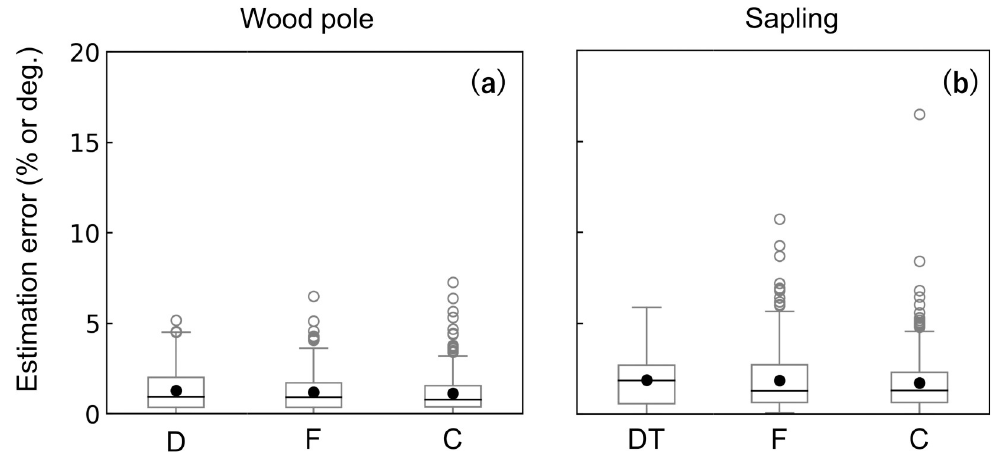
Fig 8. Box plots of all averaged estimation errors for the circumferential experiments. Results for the (a) wood pole and (b) sapling tests. F, the amount of force; C, the center of force; and D, the direction of force at h t . Each black solid circle in the panel shows the average value. For the calculation of the estimation errors for F and C, see the caption of Fig 5. The estimation error for D was defined as the absolute value of (known value)–(estimated value) (degrees).